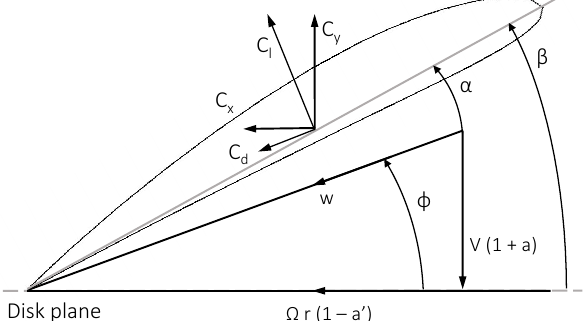
Figure 4. Velocities acting on the blade station with their corresponding angles. Nomenclature following